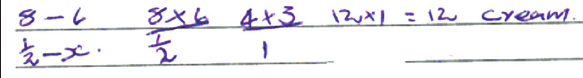
FIGURE 3: Response of Learner 15 to Question